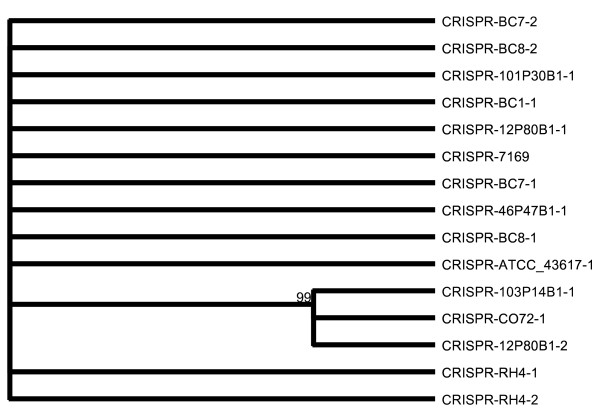
M. catarrhalis CRISPR direct repeat consensus sequences cluster into two clades. The relationship of the direct repeat (DR) consensus sequences of the 15 identified CRISPR loci were analyzed by the Neighbor-Joining method with distances calculated from the absolute number of differences with proportionally distributed gaps, computed from 1000 boot-strapping replications with random tie-braking.